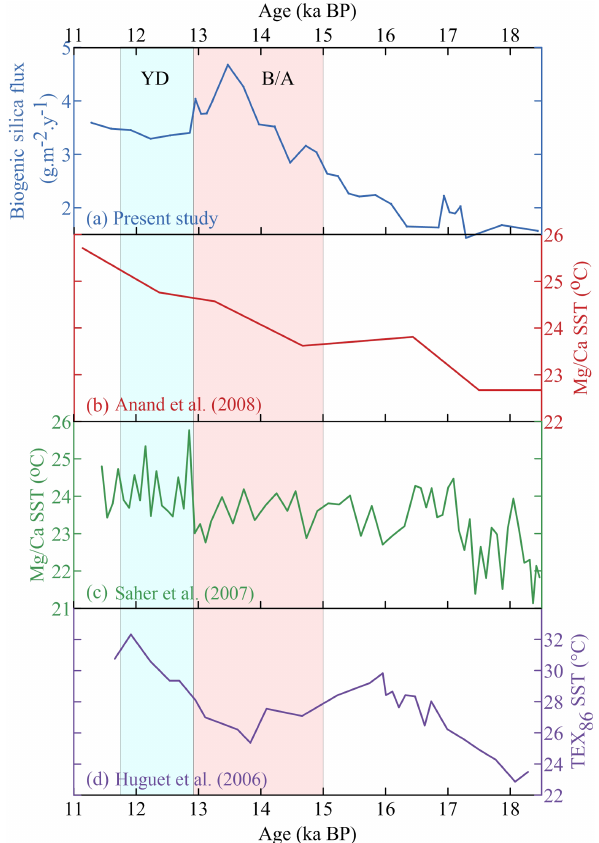
Figure 6. Comparison of the biogenic silica flux with SST records from the western Arabian Sea for the pre-Holocene period (18.5– 11.7kaBP). (a) The biogenic silica flux, (b) the Mg / Ca based SST from the NIOP-905 core (Anand et al., 2008), (c) the Mg / Ca based SST from the NIOP-929 core (Saher et al., 2007) and (d) the TEX 86 SST from the NIOP-905 core (Huguet et al., 2006).